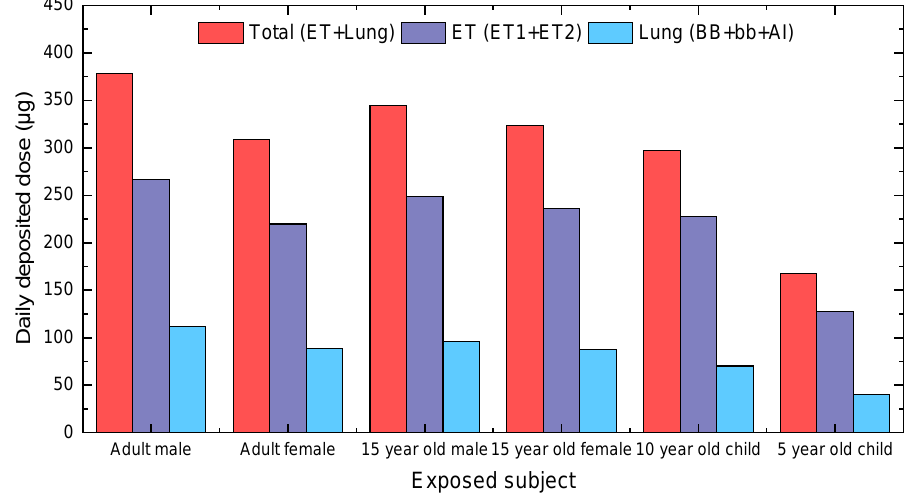
Figure 5. Total and regional cumulative deposited particle dose ( µ g) in the human respiratory tract for different characteristics of the exposed subject. The results were obtained using Lisbon